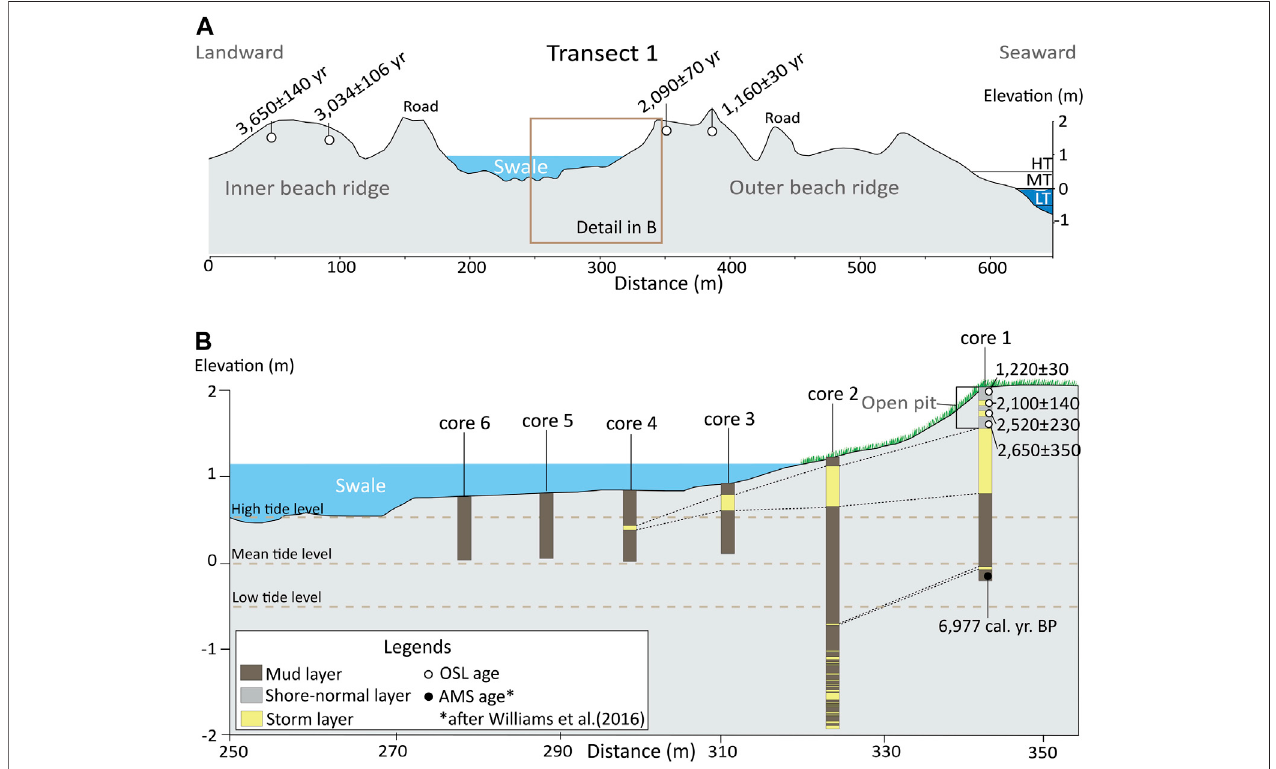
FIGURE3|(A) Cross-sectionswithirregulartopographyoftheouterbeachridge,swaleandinnerbeachridgemeasuredbyatotalstationsurveycamera.TheOSL agesofbeachridgearealsoshown. (B) Closeupoftheswalewherethelocationsofaluminumtubesandgaugecoresweredrilled.Awedge-shapedextensionofstorm sand sheet with landward thinning was observed. The OSL dating of the washover fan lobe sediment gave an age of deposition between 1,200 and 2,600 years ago.